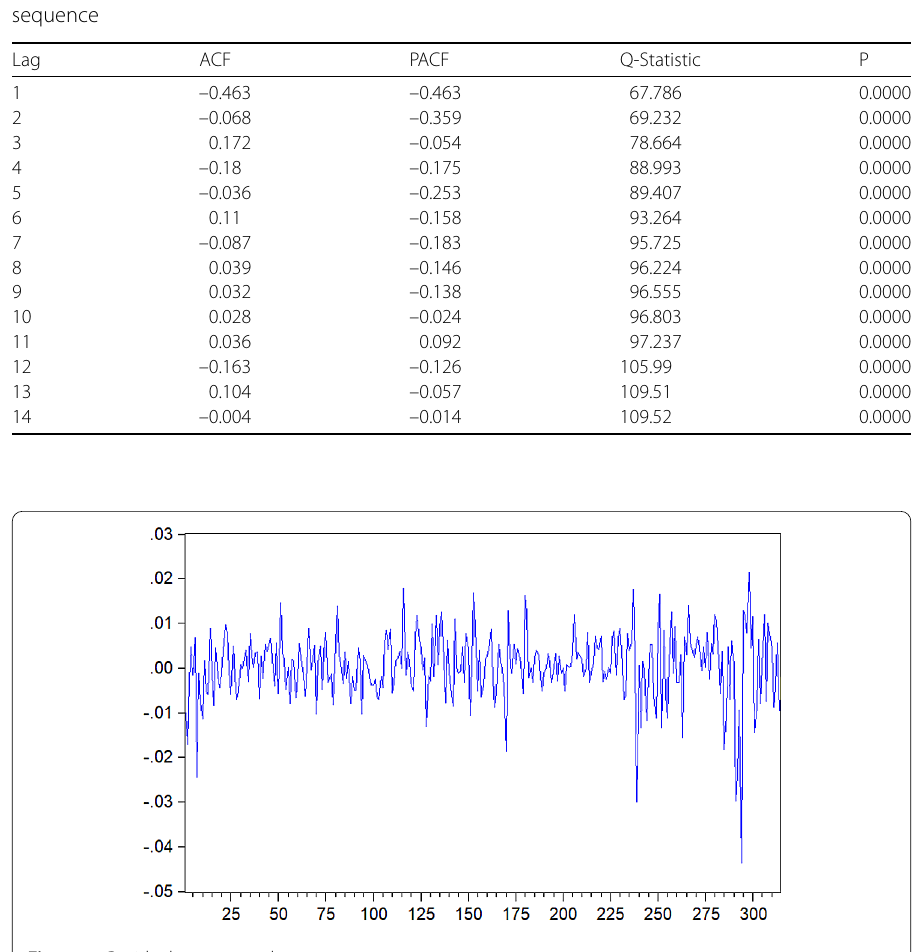
Figure 1 Residual sequence plot